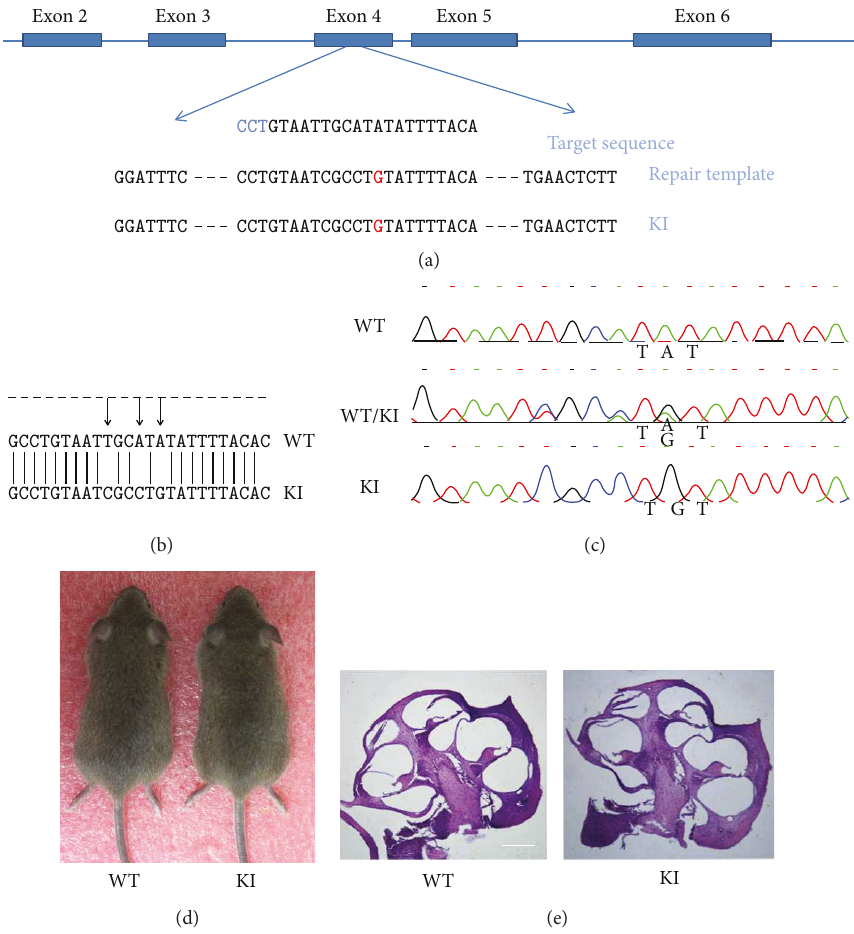
Figure 1: The generation of Myo3a mutant mice using CRISPR/Cas9. (a) Schematic diagram of targeting the mouse myosin IIIA gene. sgRNA was at exon 4 (indicated by the blue rectangles). The point mutation is in red. (b) The comparison of DNA sequences between Myo3a mutant mice (now referred to as Myo3a KI/KI mice) and wild-type mice. (c) Sequence of wild-type mice, heterozygous mice, and homozygous Myo3a KI/KI mutant mice. TAT was changed to TGT, demonstrating the missense mutation at mouse Y137C. (d) Gross morphology of Myo3a KI/KI and wild-type mice at the age of two months. There was no obvious di ff erence. (e) Cochlea morphology is normal in Myo3a mutant mice. Hematoxylin and eosin (HE) staining showed no prominent di ff erence between Myo3a mutant and wide- type mice cochlear at the age of two months. Scale bar =20 μ